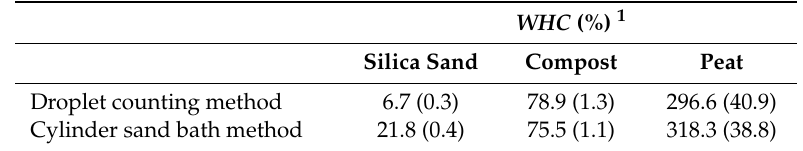
Table 4. WHC (%) of the initial soil substrates determined according to the “droplet counting method” and the “cylinder sand bath method”. Standard deviation in